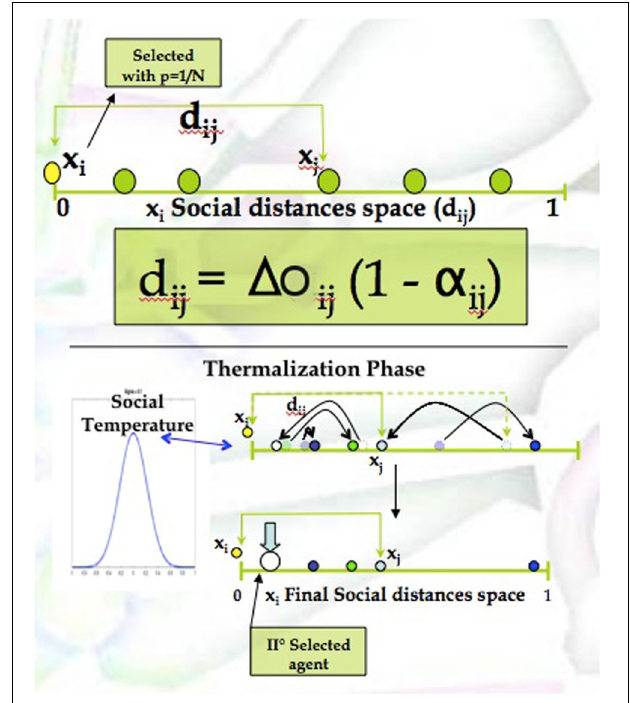
FIGURE 2 | The social distances space. Graphical representation of the mathematical recipe used to simulate the encounters dynamics among